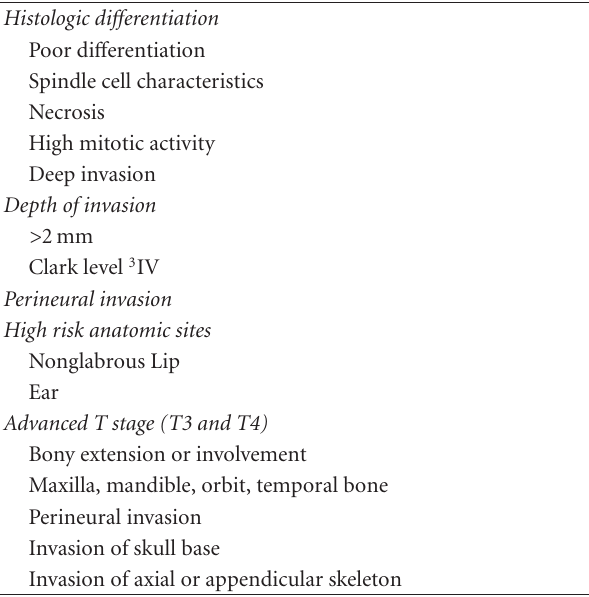
Table 1: High risk factors for NMSC tumor characteristics ∗